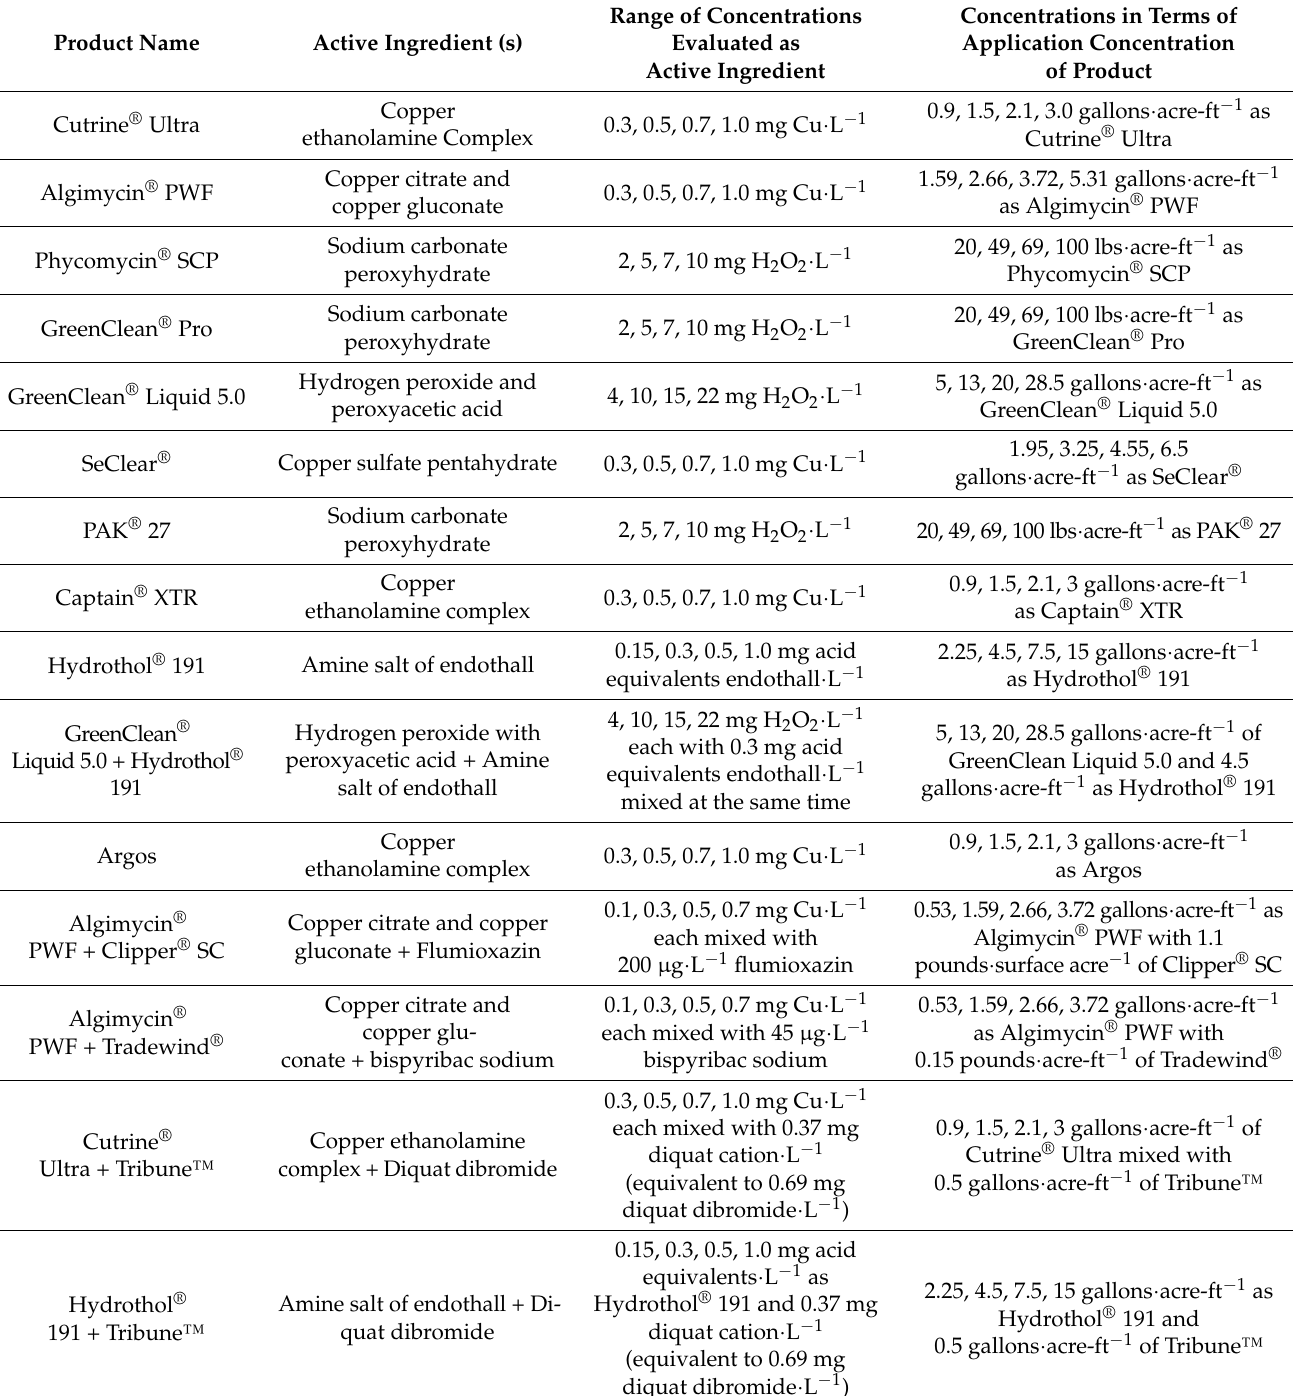
Table 2. Algaecide and herbicide formulations and concentrations